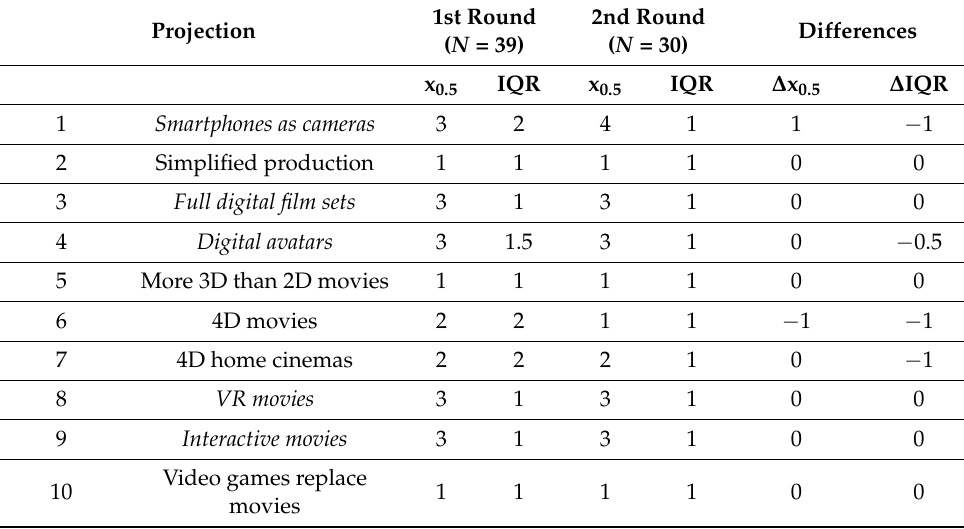
Table 2. Descriptive statistics.